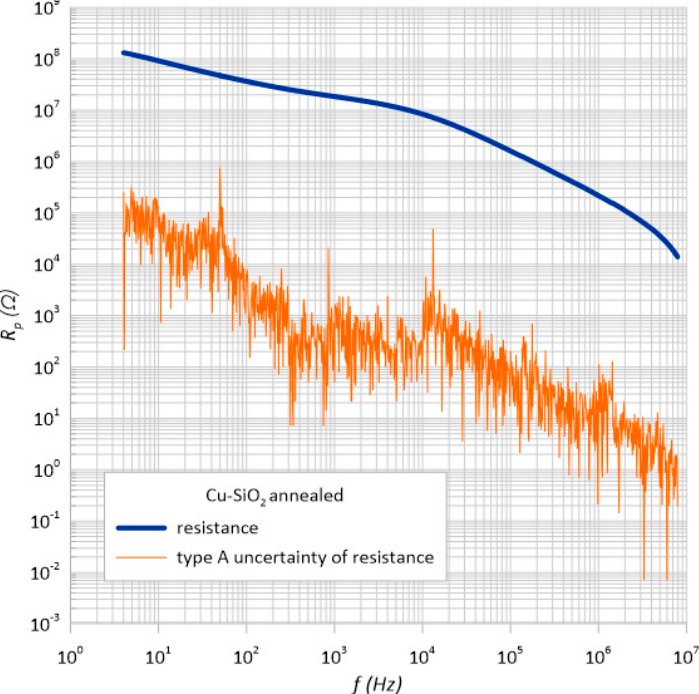
Figure 10. Frequency dependence of the resistance R p and its estimator u ( R p ) measured at room temperature after annealing at T a = 473 K.